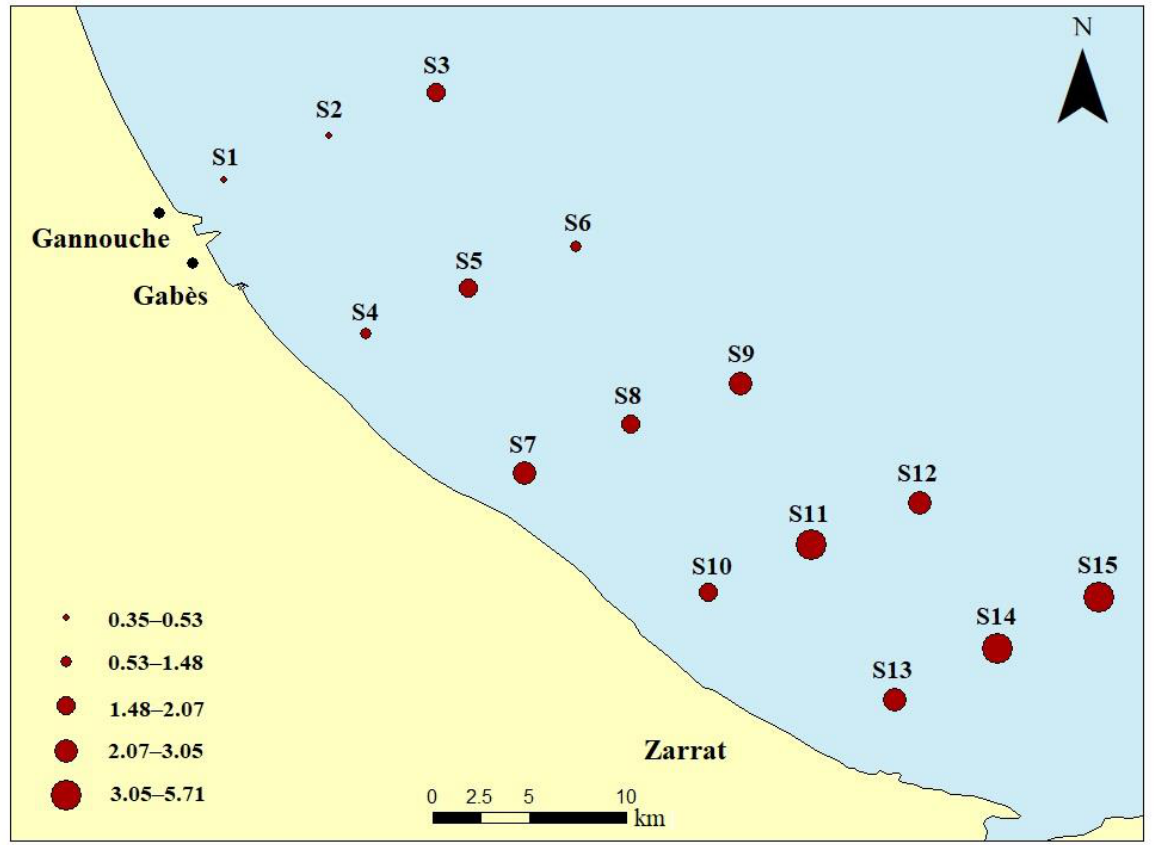
Figure 9. Spatial distribution of Copepoda sex ratio (Females/Males). Paracalanus parvus (Calanoida) dominated the Copepoda community (Figure 10), ranging from 0 (S1 and S2) to 18,300 ind · m − 3 (S13), followed by Oithona similis (Cyclopoida), which reached its highest abundance at S4 with 4900 ind · m − 3 (Figure 10). Euterpina acutifrons (Harpacticoida) ranged from 400 ind · m − 3 (S1) to 3200 ind · m − 3 (S6 and S7), and Acartia clausi fluctuated between 800 ind · m − 3 at S1 and 2900 ind · m − 3 at S8 (Figure 10). Spatial distribution of P. parvus was negatively correlated with E.I. ( ρ = − 0.84; N = 15; p < 0.001) and positively with T. nitzchoides abundance ( ρ = 0.95; N = 15; p < 0.001). The Copepoda diversity H (cid:48) ranged from 1.7 (S1) to 3.0 (S13 and S15) (ANOVA, F = 4.84, p = 0.02) (Figure 10, Table 1). H (cid:48) was negatively correlated with E.I. ( ρ = − 0.85; N = 15; p < 0.001).